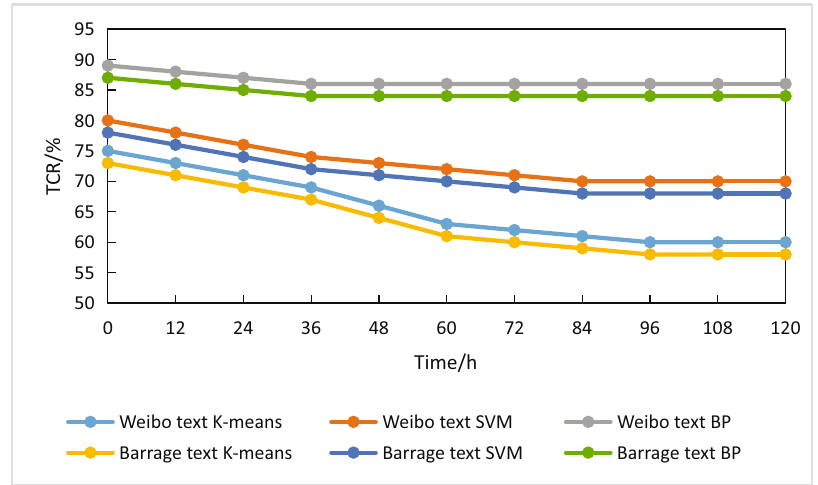
Figure 7: False alarm rates of three rumor models applied in the actual Weibo platform and bullet screen video websites within 5